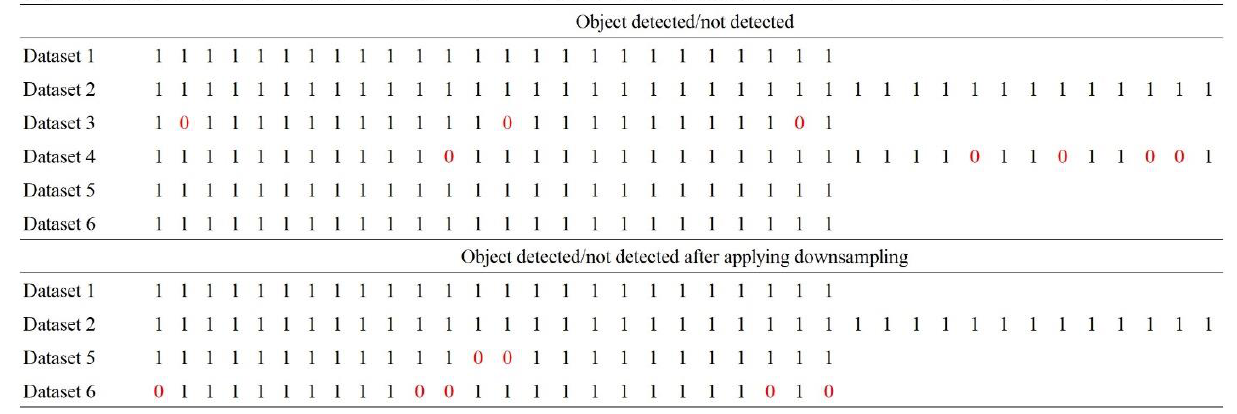
Figure 16. The results of the experiments.